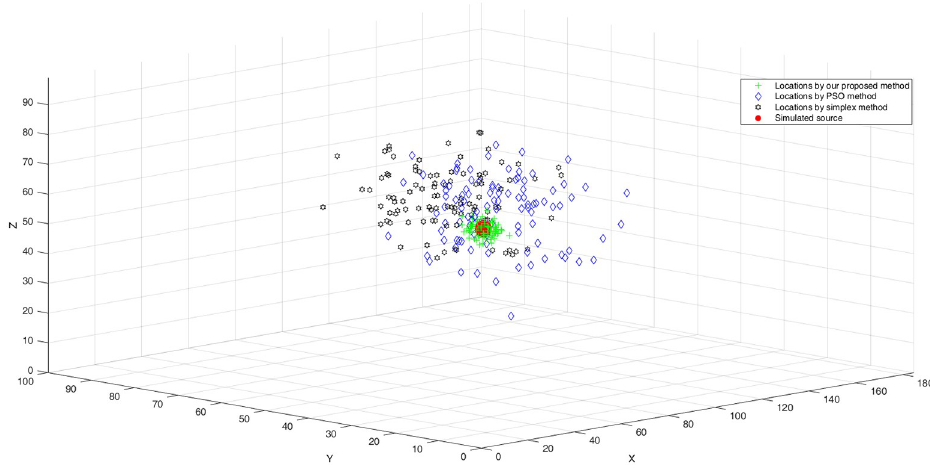
Fig 8. Location results of the proposed method compared with those of the Simplex and PSO methods in Example II.